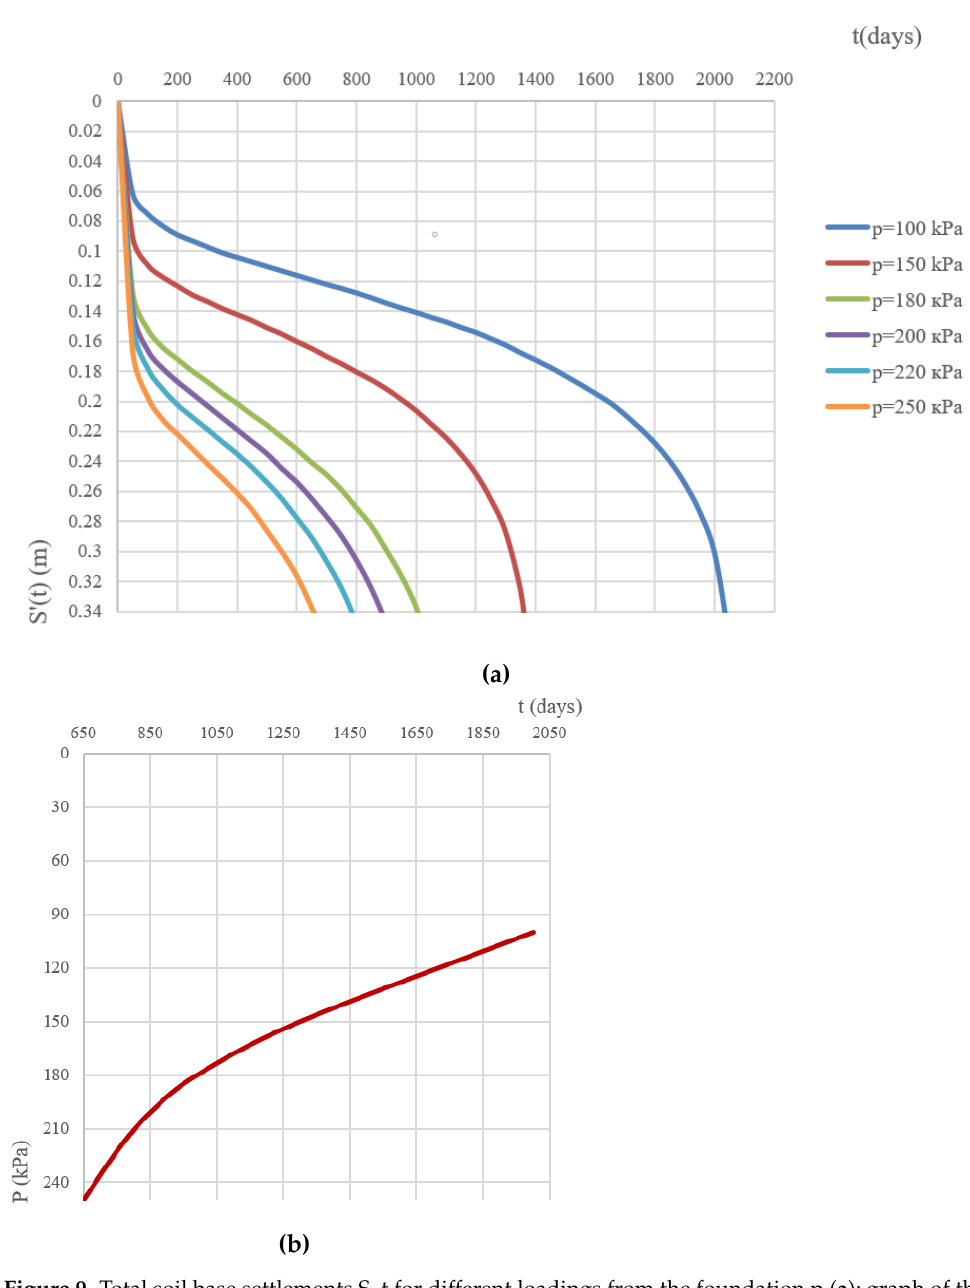
Figure 9. Total soil base settlements S–t for different loadings from the foundation p ( a ); graph of the long-term stability of the soil base ( b ).